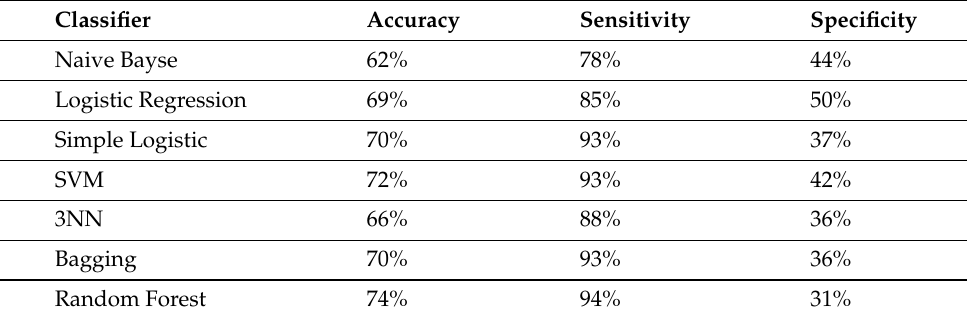
Table 3. Performance comparison between classifiers tested for cascaded classifier.